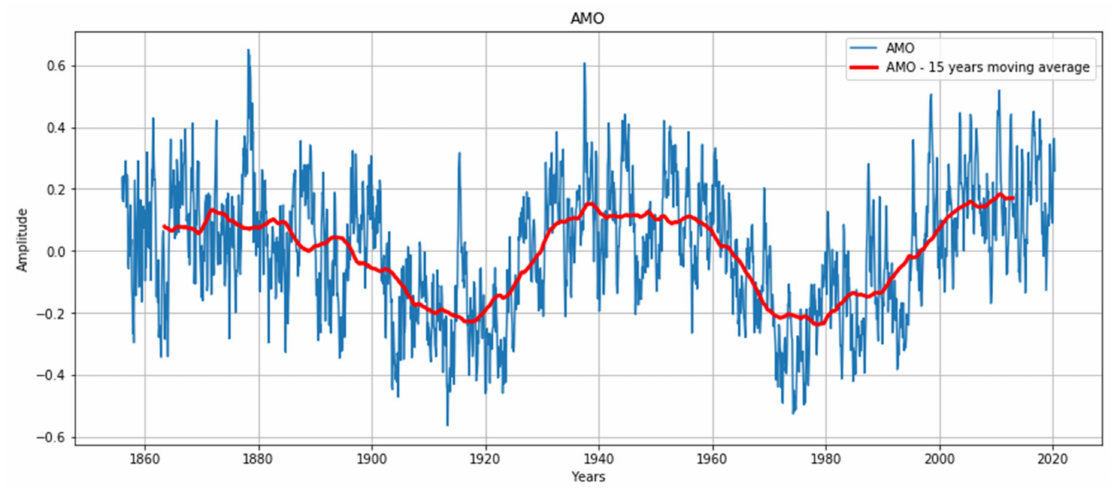
Figure 19. Time series of the AMO index (raw values and 15-year moving